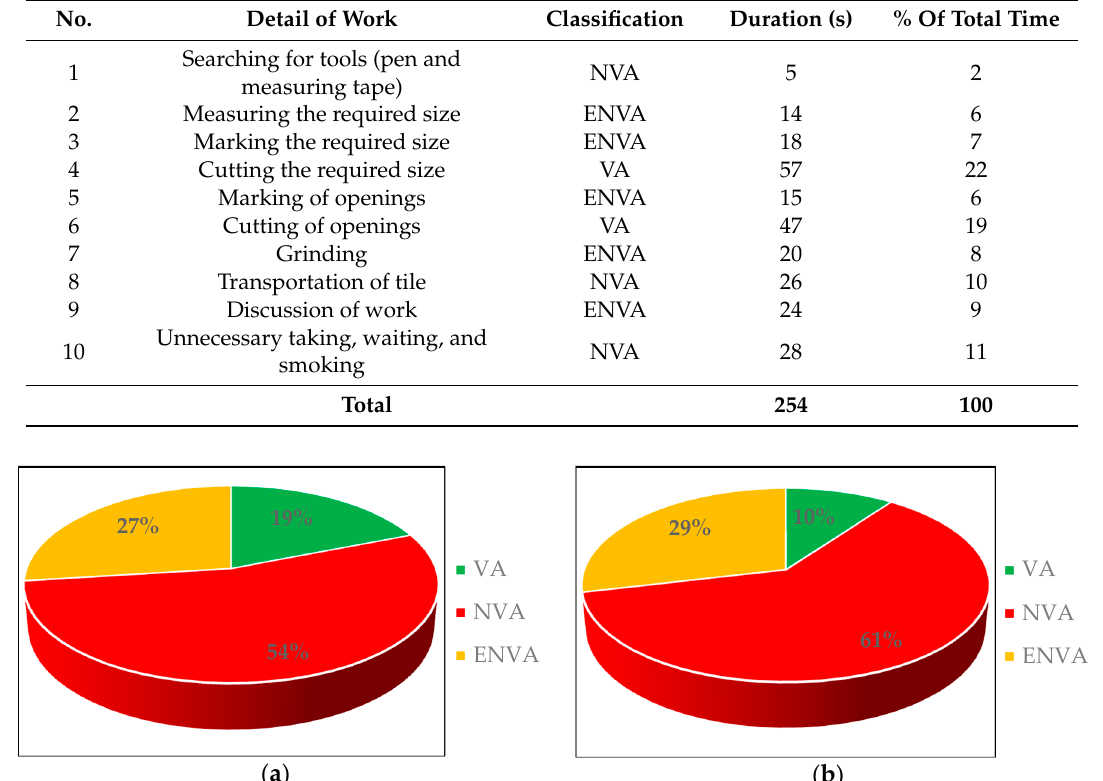
Table 3. Average data gathered from the VSM of the process “cutting tile”.